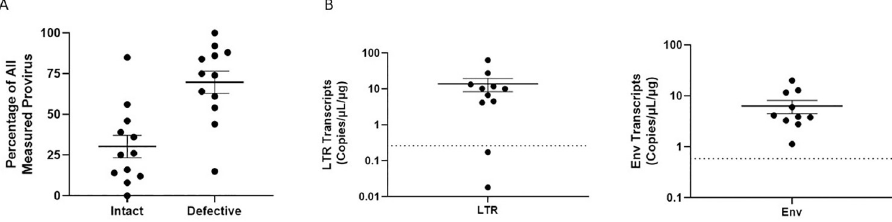
Fig 3. Detection of HIV-1 aberrant transcripts in PLWH on ART. (A) Percentage of intact and defective HIV provirus detected in DNA samples from PBMCs of HIV-positive ART-treated individuals relative to all provirus quantified by IPDA. (B) Multiplex RT-ddPCR was performed to detect intact 5’ UTR containing transcripts (LTR) and 5’ UTR-deficient env transcripts (Env) using RNA samples prepared from PBMCs of HIV-positive ART-treated individuals. No RT enzyme control reactions were carried out for each assay and background signal was subtracted from experimental readings. Dots represent estimated copies/uL of single positive transcripts per μ g of RNA. Dotted line represents the mean assay background signal calculated from five HIV-negative PBMC samples. Each point represents an independent participant sample. A total of 11 participant samples were assessed.